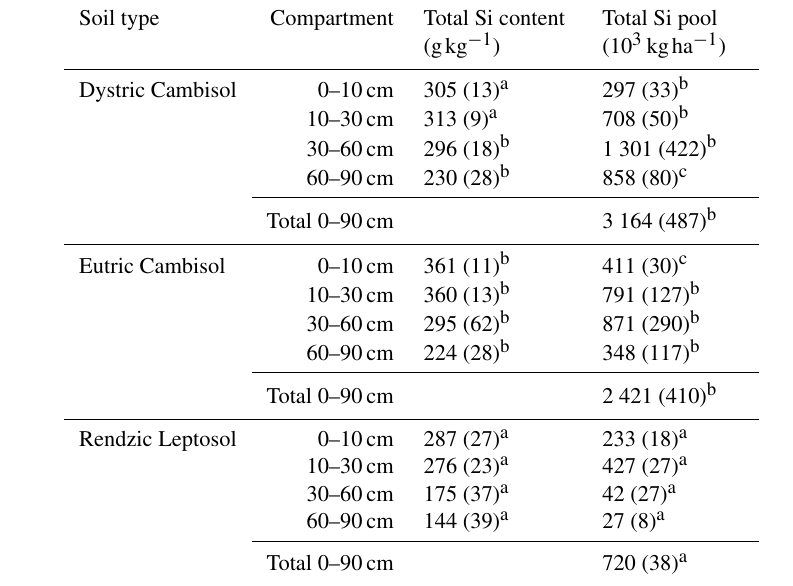
Table 3. Mean total Si content and pool in the fine earth fraction of the three soils at the Montiers site at different depths. SD values are given in brackets. Values with different letters are significantly different according to a Kruskal–Wallis test at the threshold P value level of 0.05 (soil effect; DC, EC and RL).